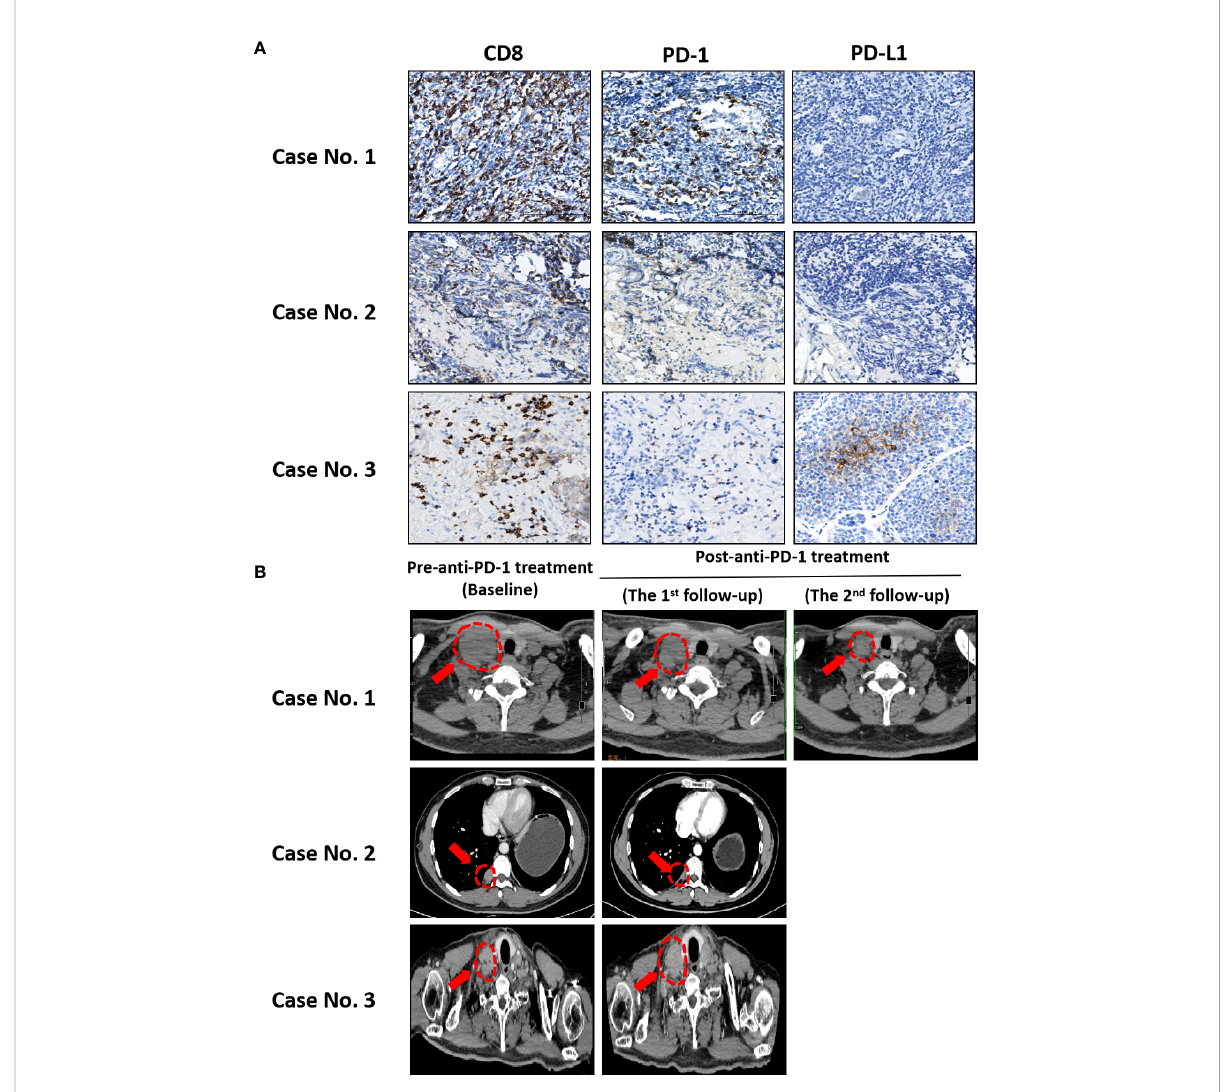
FIGURE 4 Clinical practice of ICB with toripalimab in patients with metastatic T-NEN. (A) Representative IHC images showing CD8, PD-1, and PD-L1 expression patterns in case No.1, 2, and 3. (B) CT scans at baseline (pre-anti-PD-1 treatment) and re-examinations after anti-PD-1 treatment at indicated time points are shown. The arrow points to the lesions (with red marks) that changed signi fi cantly upon toripalimab